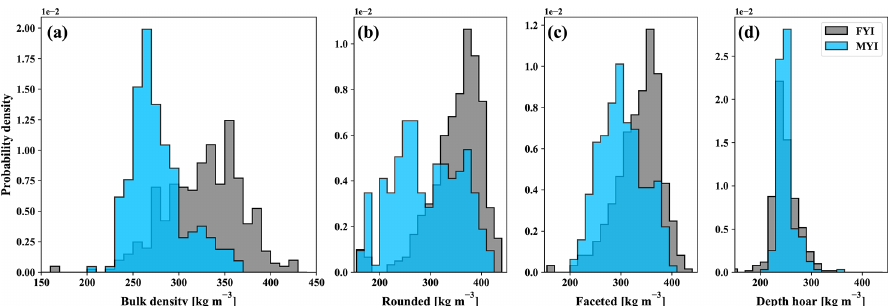
Figure 7. Bulk density (vertically integrated) derived from SMP profiles on first-year (FYI, n = 402) and multi-year (MYI, n = 211) sea ice (a) . Automated profile classification was used to separate the high-vertical-resolution (2.5mm) estimates of snow density and produce layer-type distributions for rounded (b) , faceted (c) , and depth hoar (d) classes.